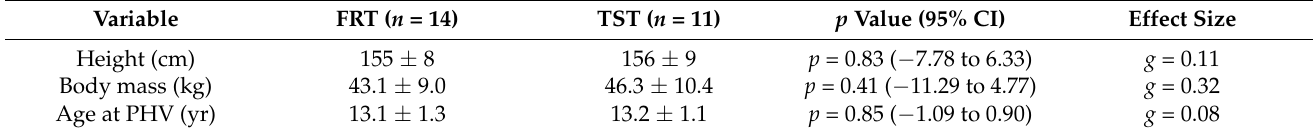
Table 1. Physical characteristics